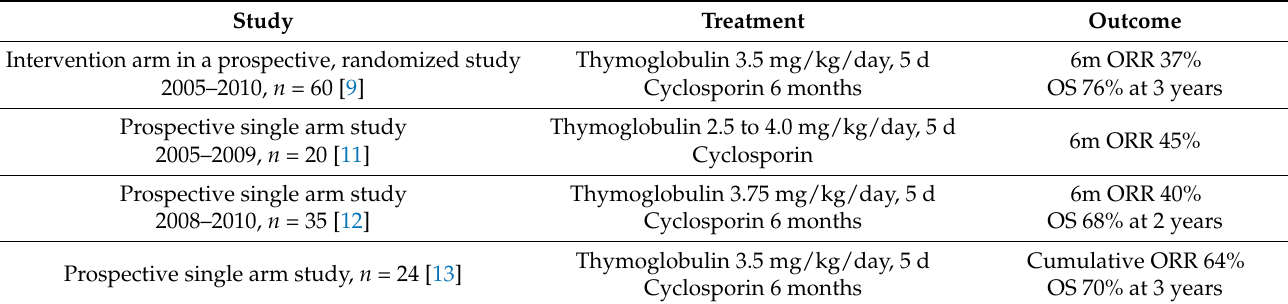
Table 2. Published prospective studies on Thymoglobuline as first line therapy in acquired AA. d: days, ORR: overall response rate, OS: overall